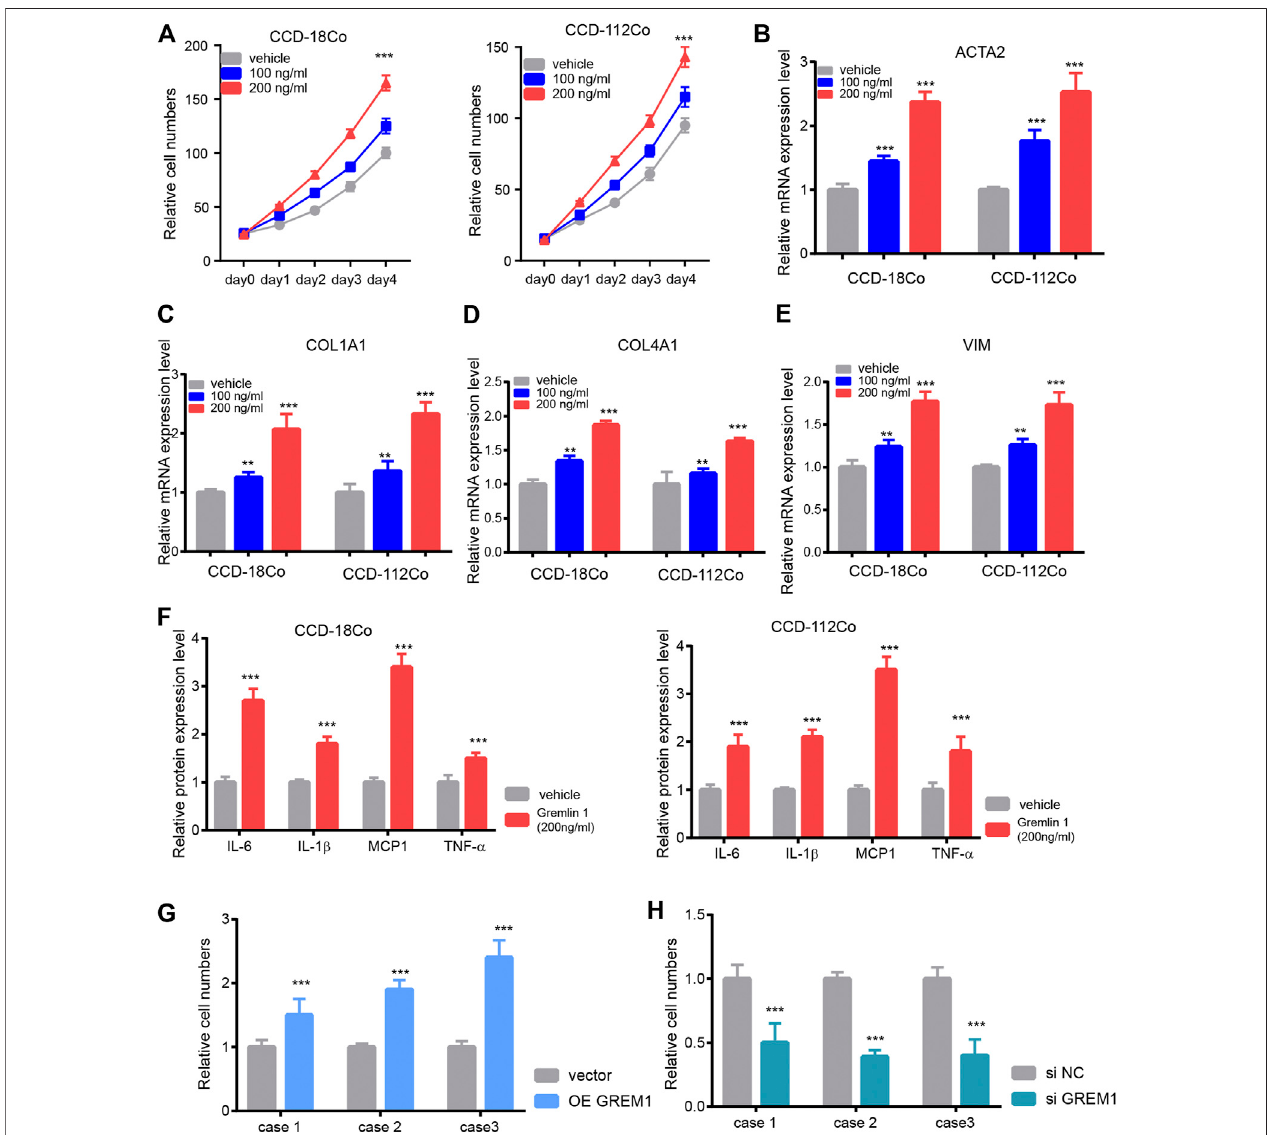
FIGURE 2 | Gremlin 1 promotes the proliferation and activation of intestinal fi broblast. (A) . Cell viability assay of human intestinal fi broblast cells CCD-18Co and CCD-112Co upondifferent doseofGremlin 1(100 and 200 ng/ml) treatment. (B – E) .TheQ-PCR results ofACTA2 (B) , COL1A1 (C) ,COL4A1 (D) andVIM (E) ,intestinal fi broblastcellsCCD-18CoandCCD-112Coupon100and200 ng/mlofGremlin1treatmentfor24 h. (F) .Thefoldchangesofin fl ammationcytokinesinhuman fi broblast cells CCD-18Co and CCD-112Co upon 200 ng/ml Gremlin 1 treatment for 24 h. (G) . The system of fi broblast and intestinal organoid culture system. (H – I) . The relative IL-1 β level in the culture medium of the human intestinal organoid upon co-cultured with GREM1 gene overexpressed fi broblast cell (H) or GREM1 gene knockdown fi broblast cell (I) for 48 h. These experiments were repeated twice. p values are derived from one-way ANOVA analysis. Dunnett ’ s test was used to analysis the difference between control group to the other groups. ** p ≤ 0.01; *** p ≤